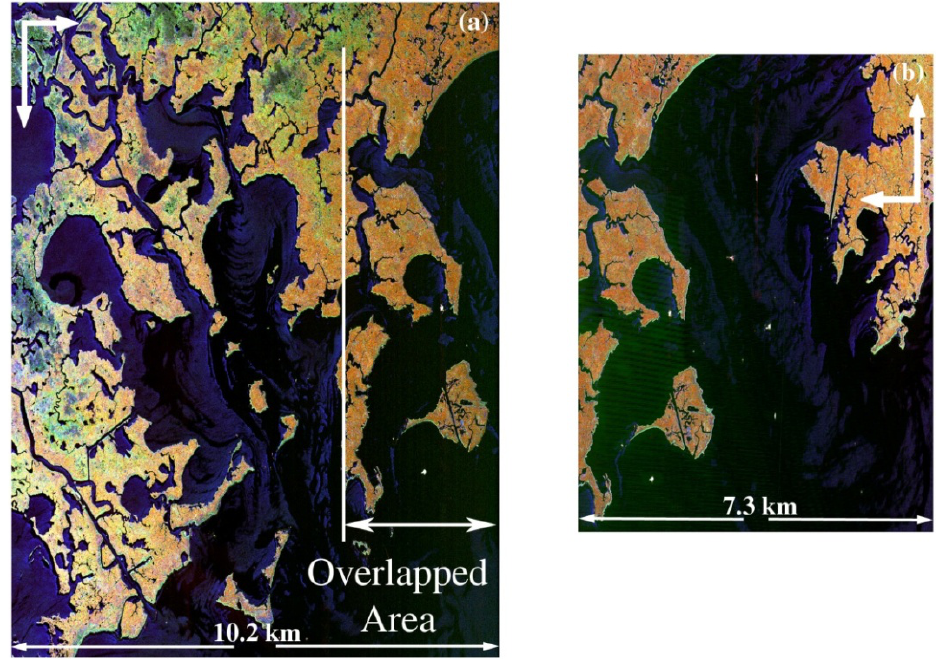
Figure 8. Multi-polarization MLC backscatter intensity data for (a) the Barataria Bay (BB) and (b) the Grand Isle (GI) flight lines with the overlapping region in the BB, GI, and MRD lines shown. Color composites in the images shown are HH (red), HV (green), and VV (blue) (common color tables were used for the MRD, BB, and GI flight